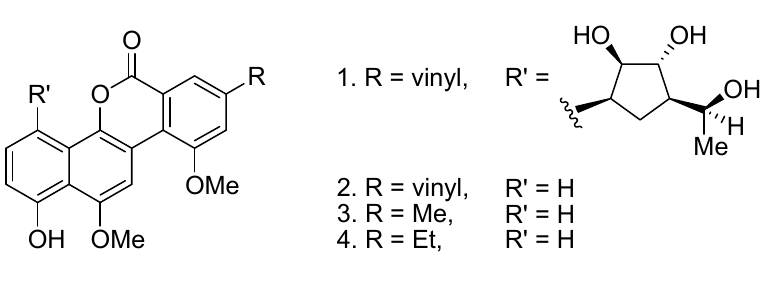
Figure 1. Examples of